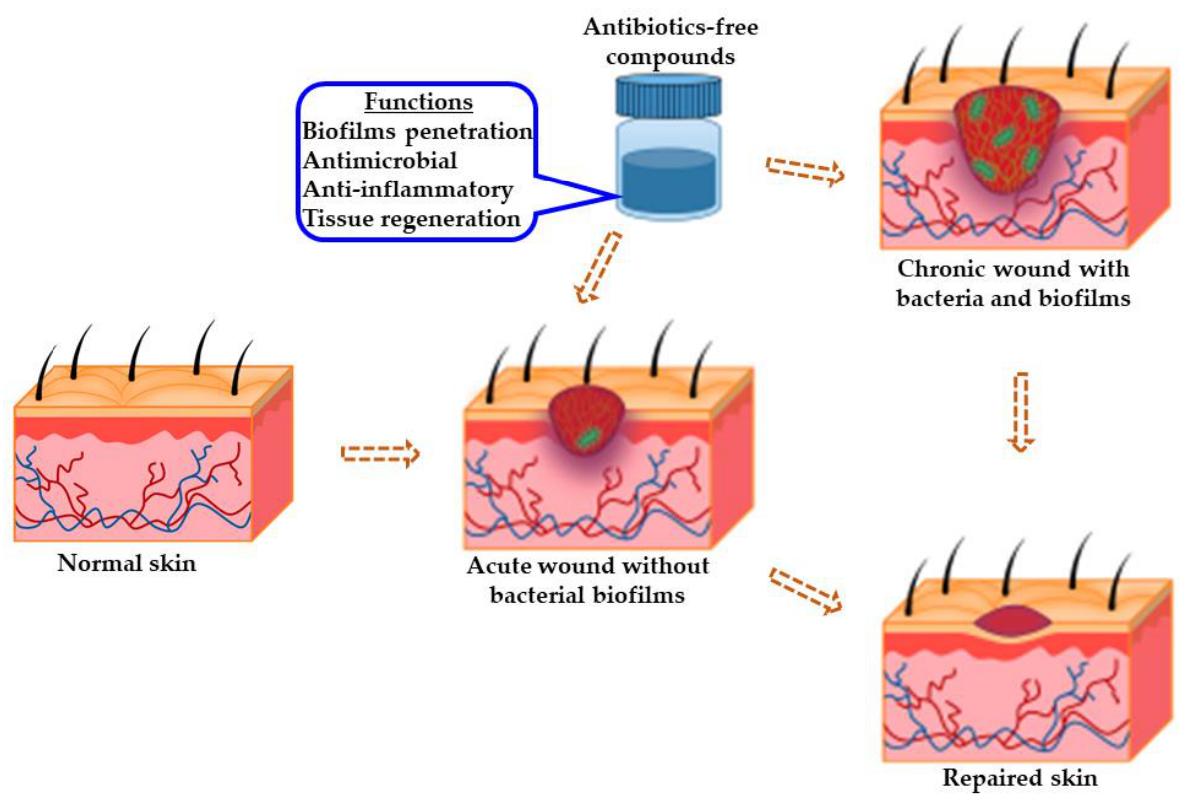
Figure 3. Schematic diagram showing the functionalities of antibiotics-free compounds towards wound healing. The morphology of healthy skin is distinct from that of chronic wounds due to defects in CWs ’ skin anatomy and high invasive bacteria loads. Antibiotics-free compounds can serve as prophylactic or chronic wound care agents when alone or in formulation with antibiotics.